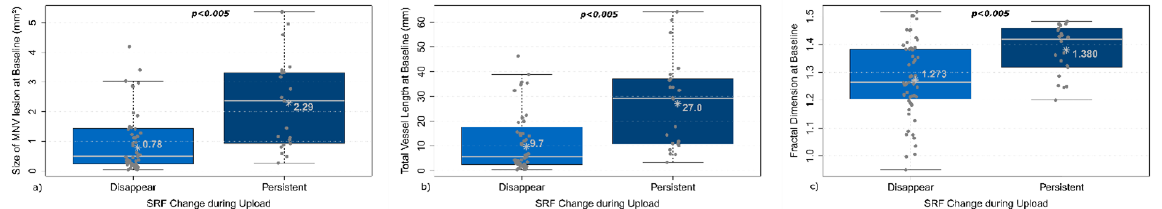
Figure 3. Boxplots showing the distribution of the area ( a ), total vascular length ( b ), and fractal dimension ( c ) of the MNV at the time of initial diagnosis in relation to the absorption or persistence of subretinal fluid after three intravitreal injections of anti-VEGF. Each dot represents an individual measurement. The boxes enclose the measurements between the uppermost and lowermost quar- tiles. The whiskers show the last measurements within the 1.5-fold interquartile range. * = Mean, bar = median; Wilcoxon rank-sum